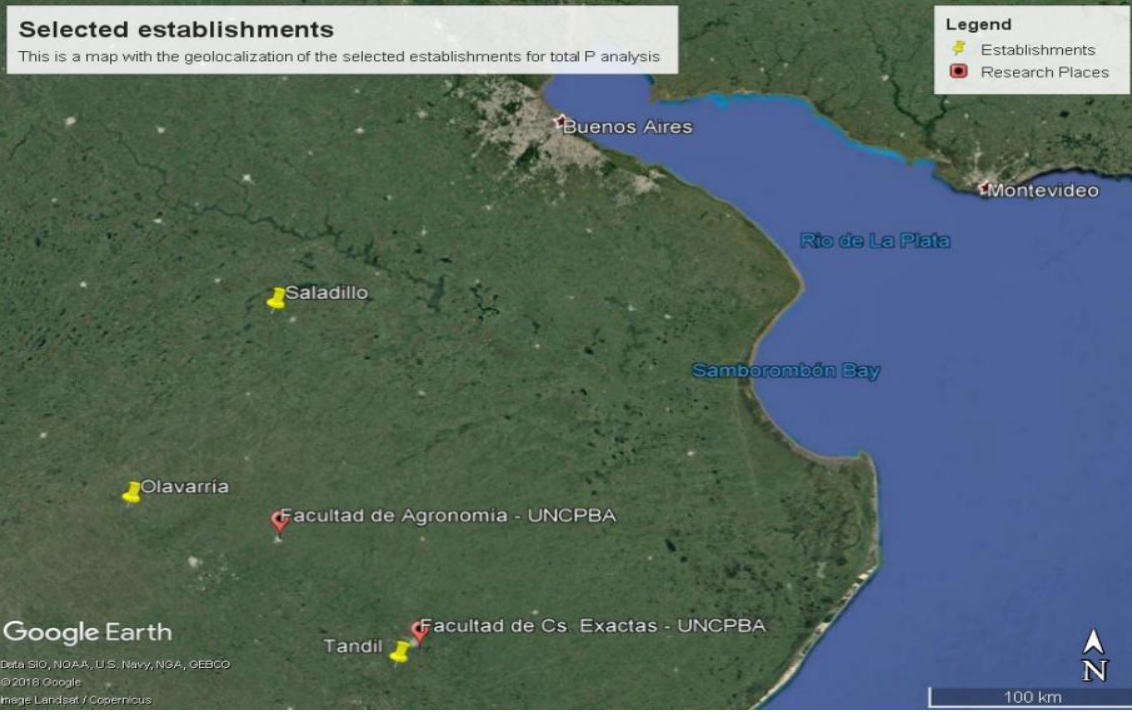
Fig. 1 A map with the georeferenced concentrated animal feeding operations (Google, n.d. 2021